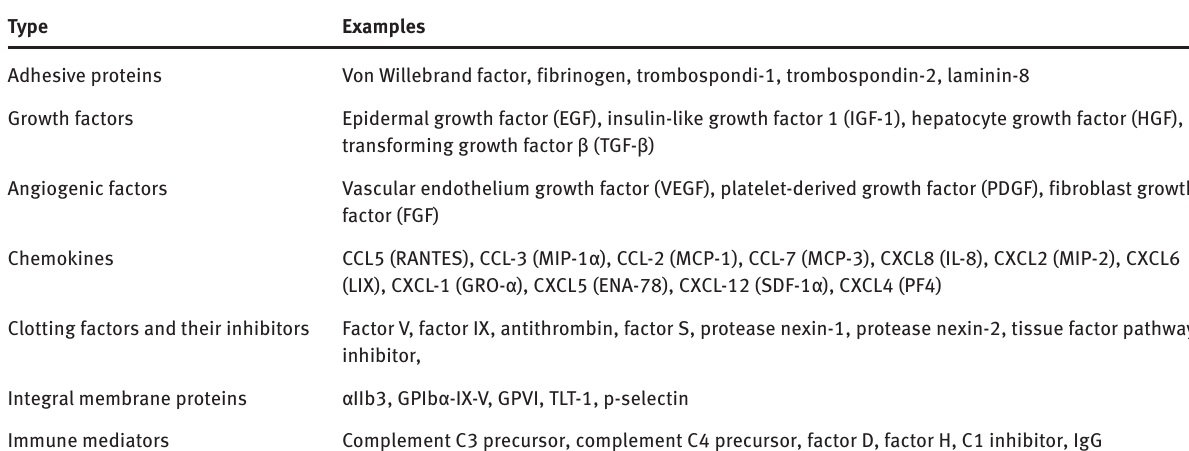
Table 1: Platelet α-granule content